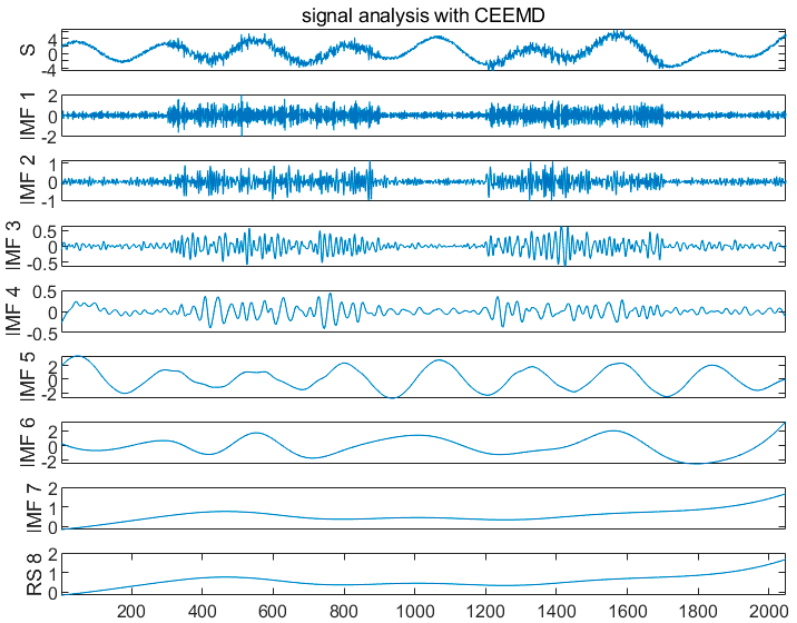
Figure 4. Seven sub-signals decomposed by complementary ensemble empirical mode decomposition (CEEMD).